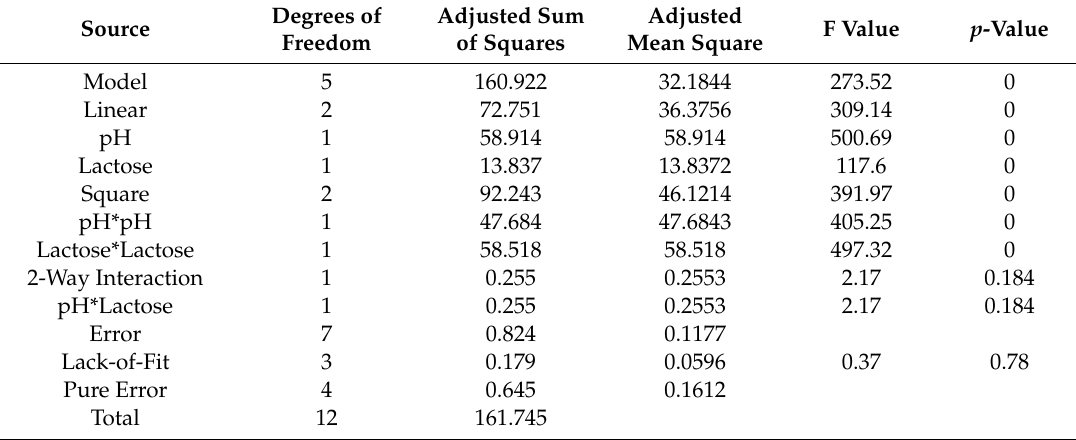
Table 9. ANOVA for the response surface quadratic model from central composite design (based on specific enzyme